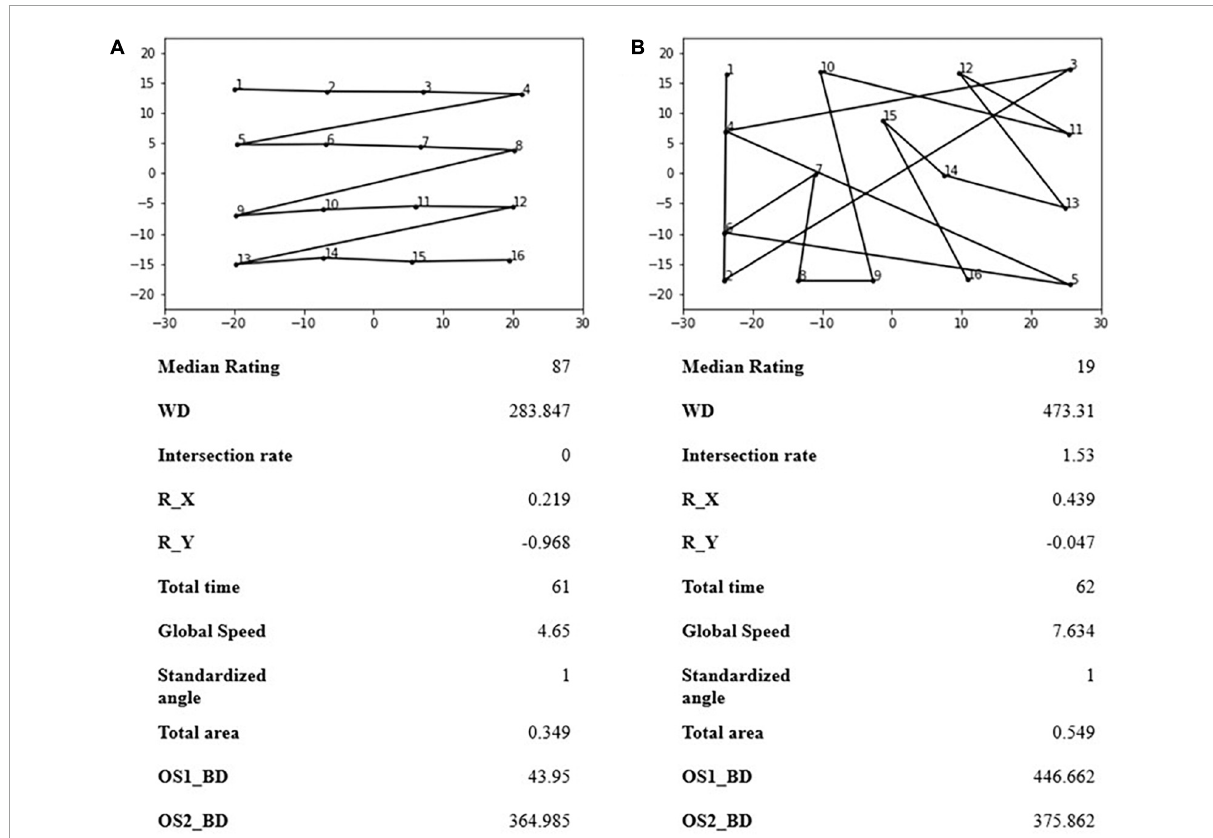
FIGURE4 Two examples of E-BTT sequences, one (A) evaluated as organized and the other (B) with low subjective ratings of organization. OS1_BD, between distance from optimal sequence number 1 (a sequence characterized by a sawtooth by rows); OS2_BD, between distance from optimal sequence number 2 (a sequence characterized by a sawtooth by